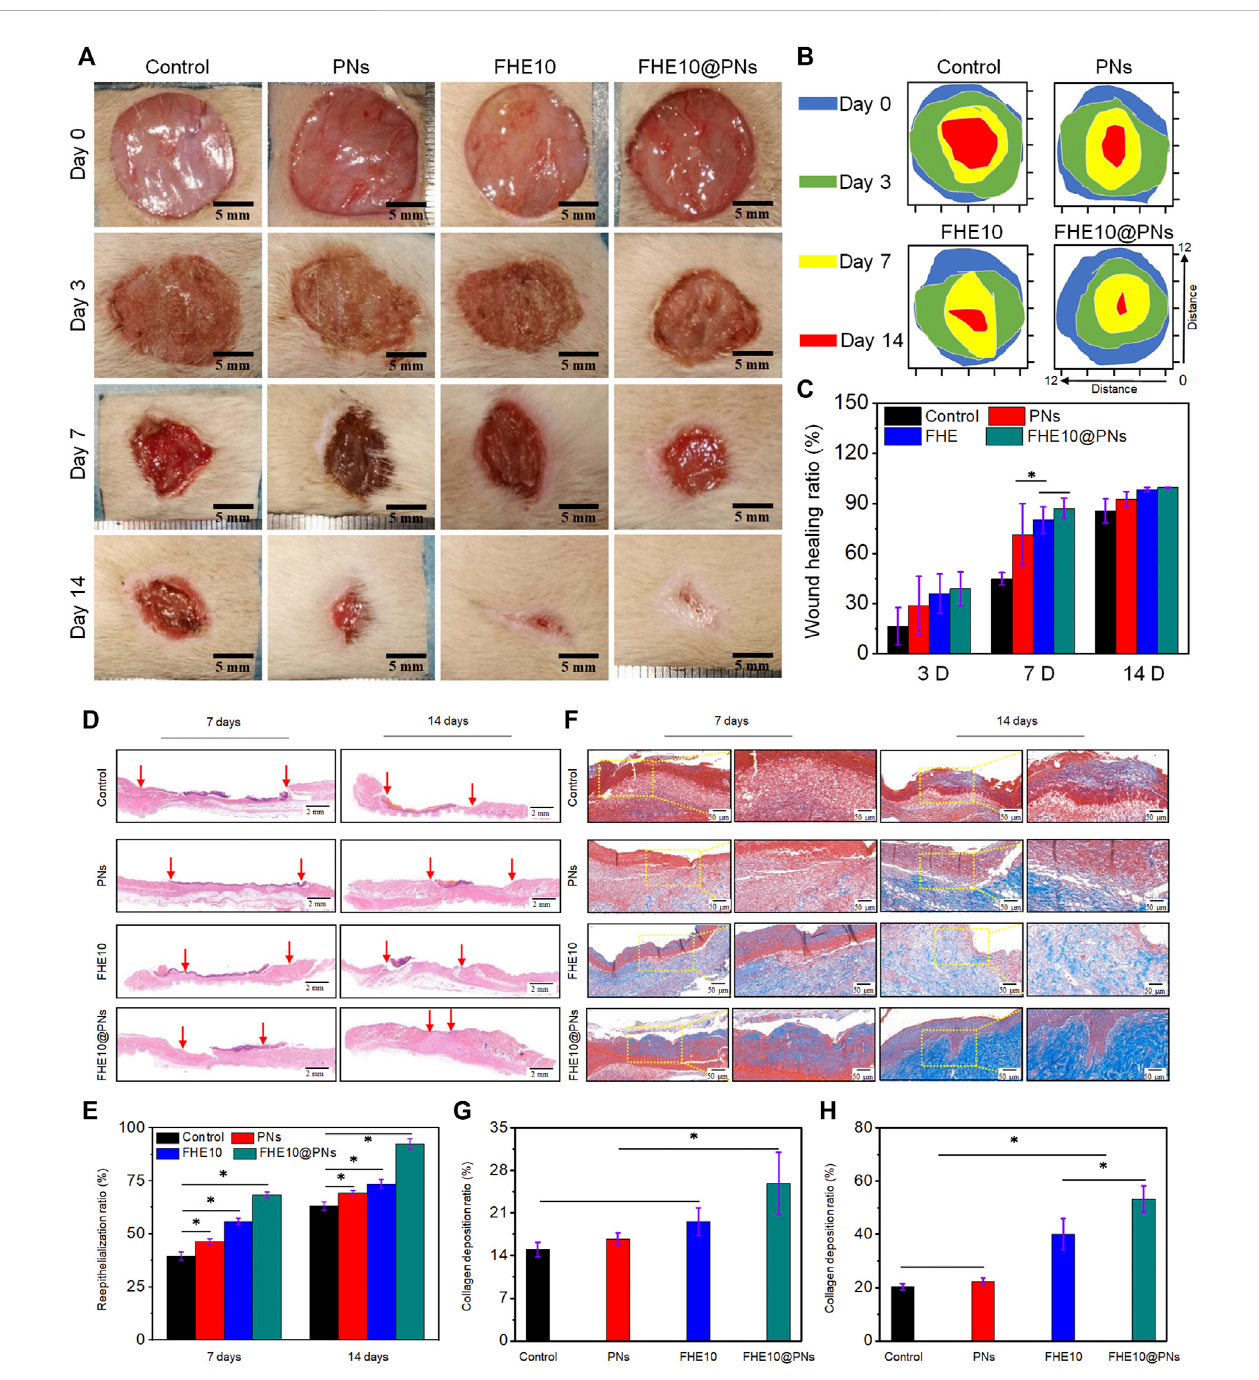
FIGURE 5 (A) Woundimages ofcontrol,PNs,FHE10,FHE10@PNsat0,3,7and 14 days post-operation; (B) Traces ofwoundrepairforeachtreatment group invivo . Blue, green,yellow, and redareascorrespondto thewoundareaatn( n =0,3, 7and 14)days,respectively; (C) Wound healing ratioofthedefects treated with saline (control), PNs, FHE10, FHE10@PNs at 0, 3, 7 and 14 days post-operation; (D) H&E stained images; (E) The reepithelialization rate of wound defect at 7and 14 daysafter treatment withsaline(control),PNs, FHE10,andFHE10@PNs; (F) Masson ’ strichrome stainedimages; (G,H) Thecollagendeposition in the wound sites was evaluated by